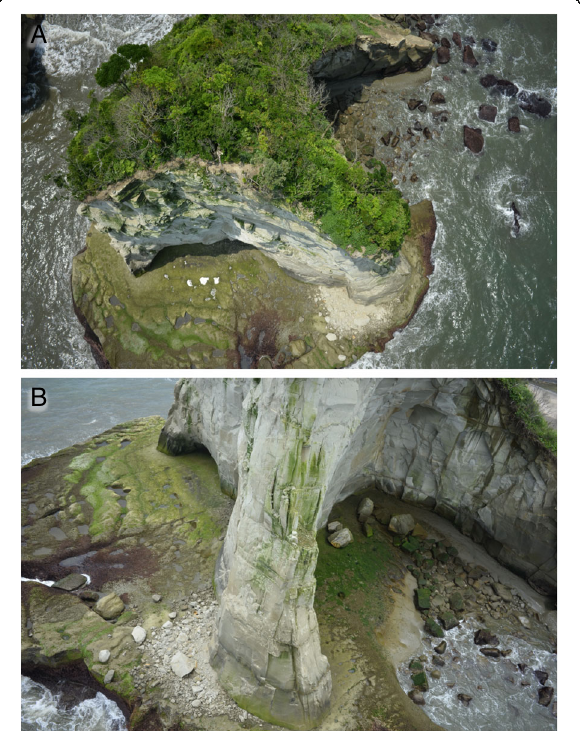
Fig. 2 Examples of aerial photographs of Suzumejima taken by UAV on June 17, 2015. a Taken from above the island (west on top) and b ) taken from the north